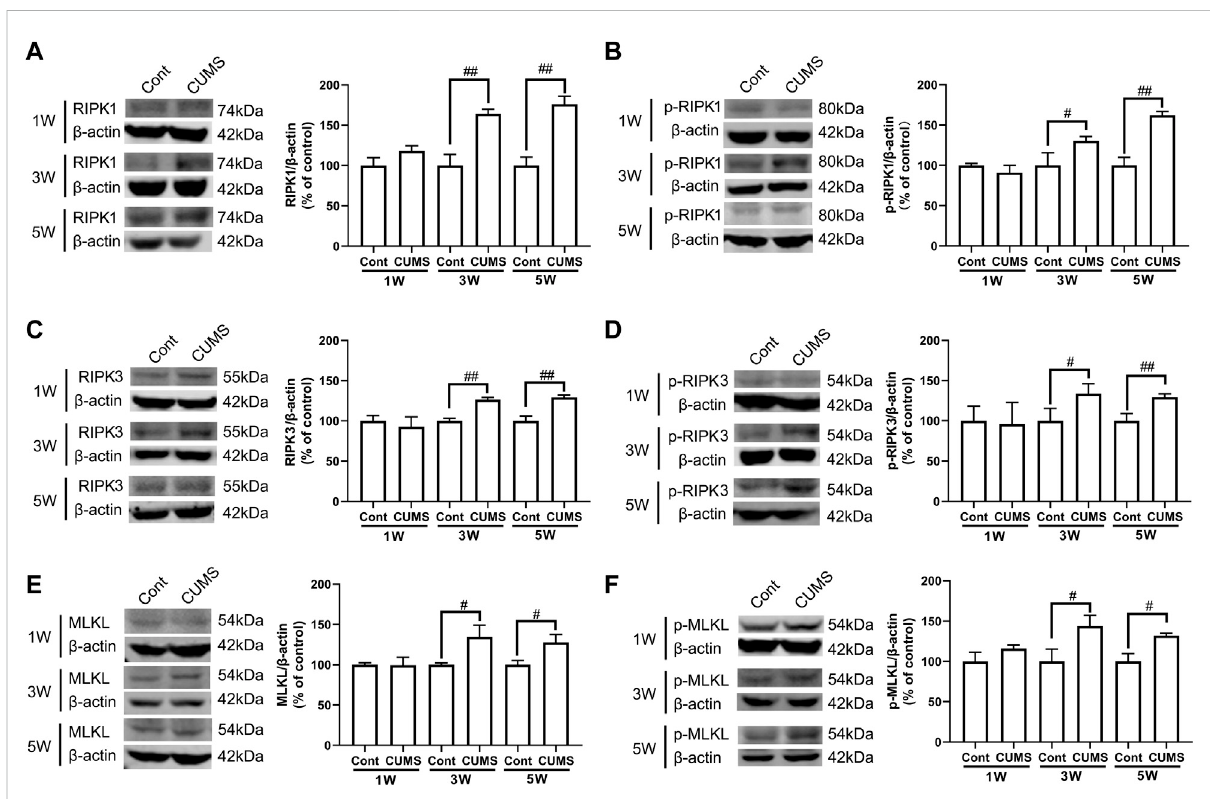
FIGURE 2 CUMStreatmentinducestheactivationofnecroptotickinasesinthemousehippocampusinatime-dependentmanner.MiceweretreatedwithCUMS for1,3and5 weeks.TheexpressionofRIPK1 (A) /p-RIPK1 (B) ,RIPK3 (C) /p-RIPK3 (D) ,andMLKL (E) /p-MLKL (F) inthehippocampusofCont-orCUMS-treated mice over different time courses, as determined by Western blotting analysis. β -actin protein was used as a loading control. ImageJ software was used for immunoblotting quanti fi cation, and statistics were performed by Student ’ s t test . Mean ± SD , n = 3 per group, # p < 0.05, ## p < 0.01 vs. Cont.